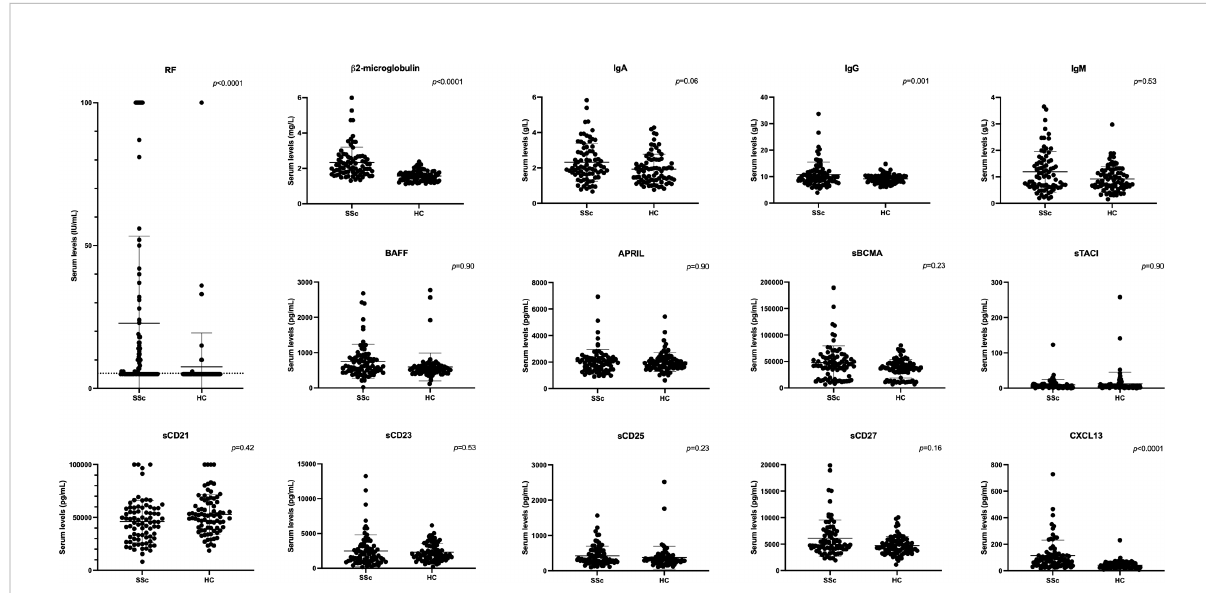
FIGURE 1 Serum levels of soluble markers of B cell activation in SSc patients and healthy controls (discovery cohort). APRIL, a proliferation-inducing ligand; BAFF, B-cell-activating factor; BCMA, B-cell maturation antigen; CD, cluster of differentiation; CXCL13, C-X-C motif chemokine 13; HC, healthy controls; Ig, immunoglobulin; RF, rheumatoid factor; s, soluble; SSc, systemic sclerosis; TACI, transmembrane activator and CAML interactor. The dotted line on the RF panel represents the threshold for RF positivity. Error bars display means and standard deviations. p -values are adjusted for age, gender and multiplicity. The p -value displayed on the RF panel refers to the analysis using RF as a binary